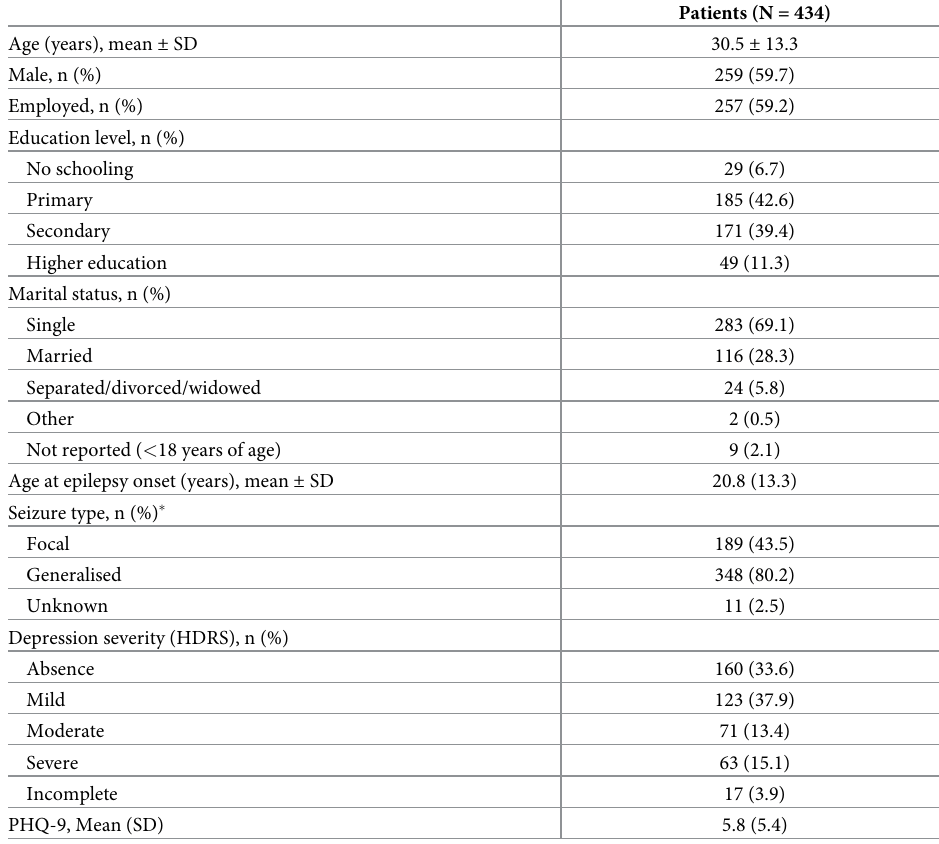
Table 2. Sociodemographic and clinical characteristics of